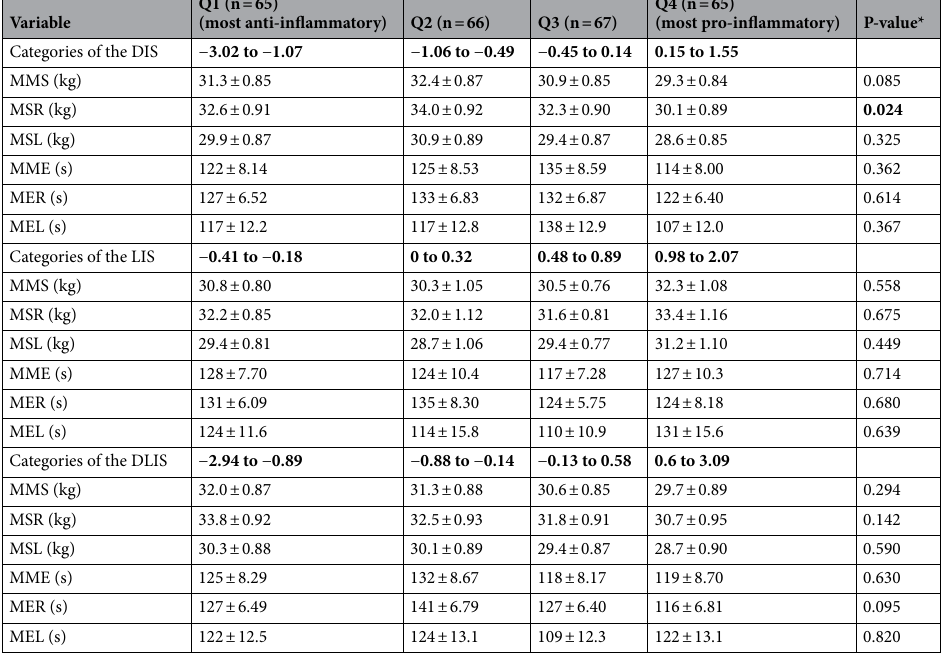
Table 3. Multivariate adjusted means for muscle strength and muscle endurance across quartile of the dietary inflammation score (DIS), lifestyle inflammation score (LIS), and the dietary and lifestyle inflammation score (DLIS) for the participants, separately. MMS, Mean muscle strength; MSL, Muscle strength of left hand, MSR; Muscle strength of right hand, MME, Mean muscle endurance; MEL, Muscle endurance of left hand, MER; Muscle endurance of right hand; Q, quartile; S, second. Obtained from ANCOVA test. all values are adjusted for age, sex, energy intake, marriage status, occupation, and education status. DIS was adjusted further for body mass index, physical activity, and smoking status. P < 0.05 is significant. Significant values are in